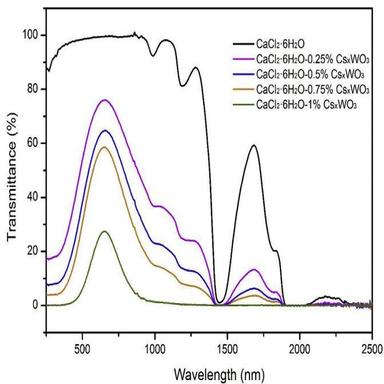
UV–vis-IR transmittance spectra of the CaCl2·6H2O with different mass ratio of CsxWO3 nanoparticles.